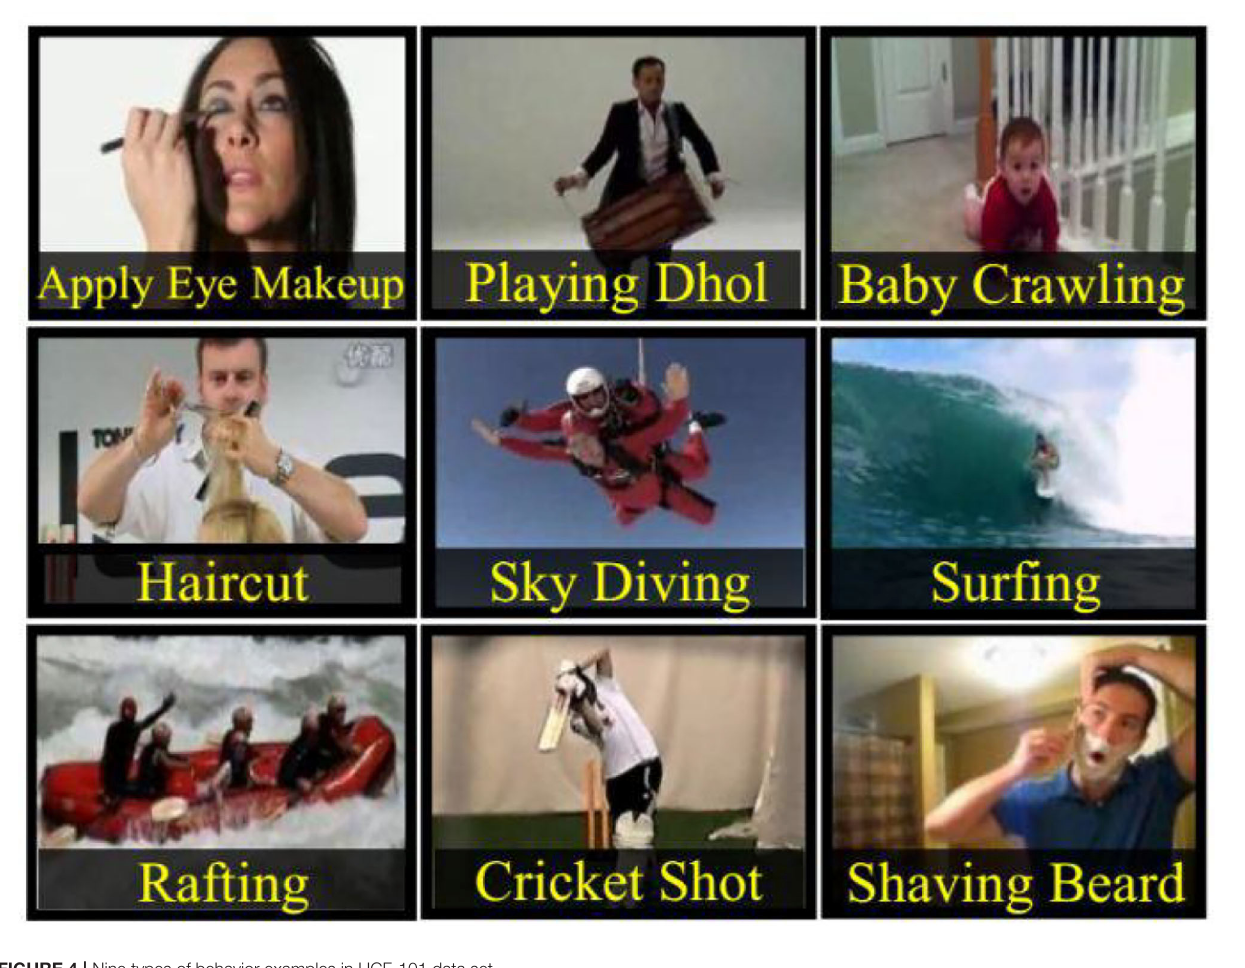
FIGURE 4 | Nine types of behavior examples in UCF-101 data set.